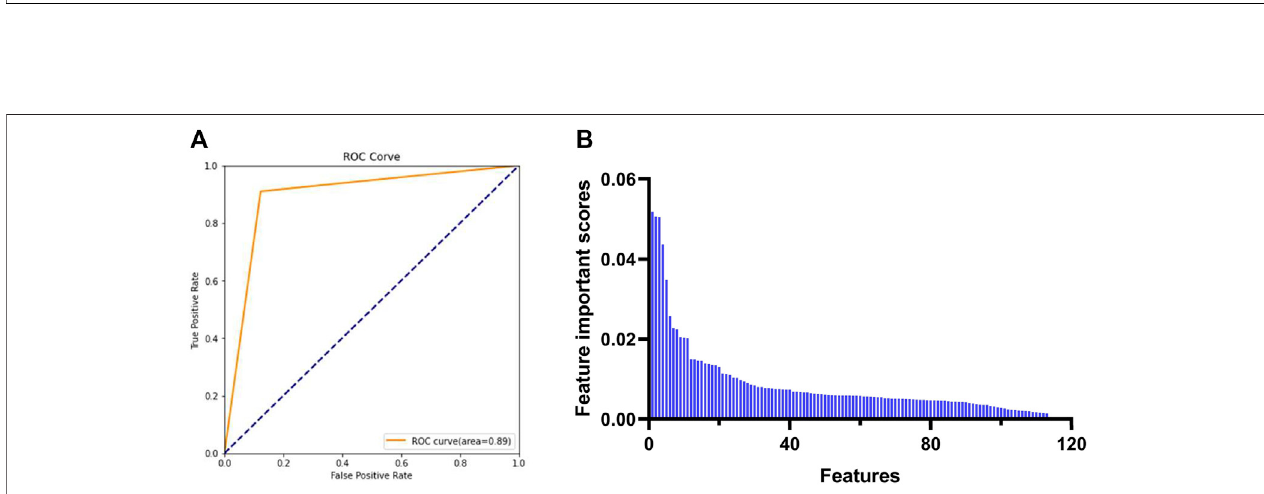
FIGURE3| SelectionoffeaturedescriptorsbasedonRandomForestmodel. (A) AUCofRandomForestmodelunderthebestparameters. (B) Featureimportance scores calculated by the Random Forest model. AUC: area under receiver operating characteristic curve.